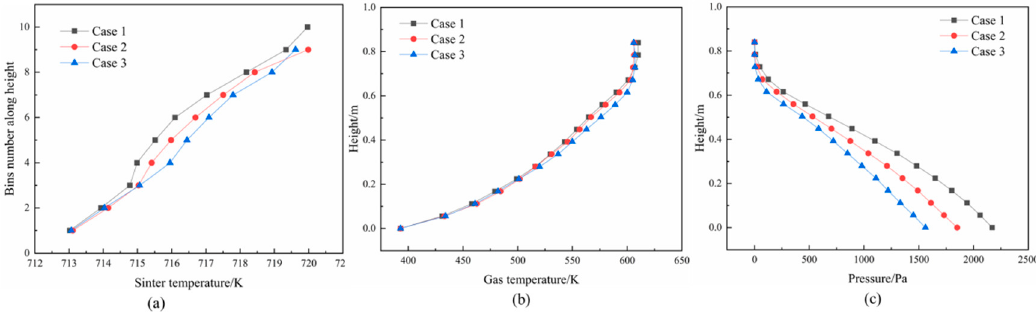
Figure 8. Distribution of sinter temperature, cooling gas temperature and cooling gas pressure for Cases 1~3. ( a ) Sinter temperature distribution; ( b ) gas temperature distribution; ( c ) cooling gas pressure distribution.